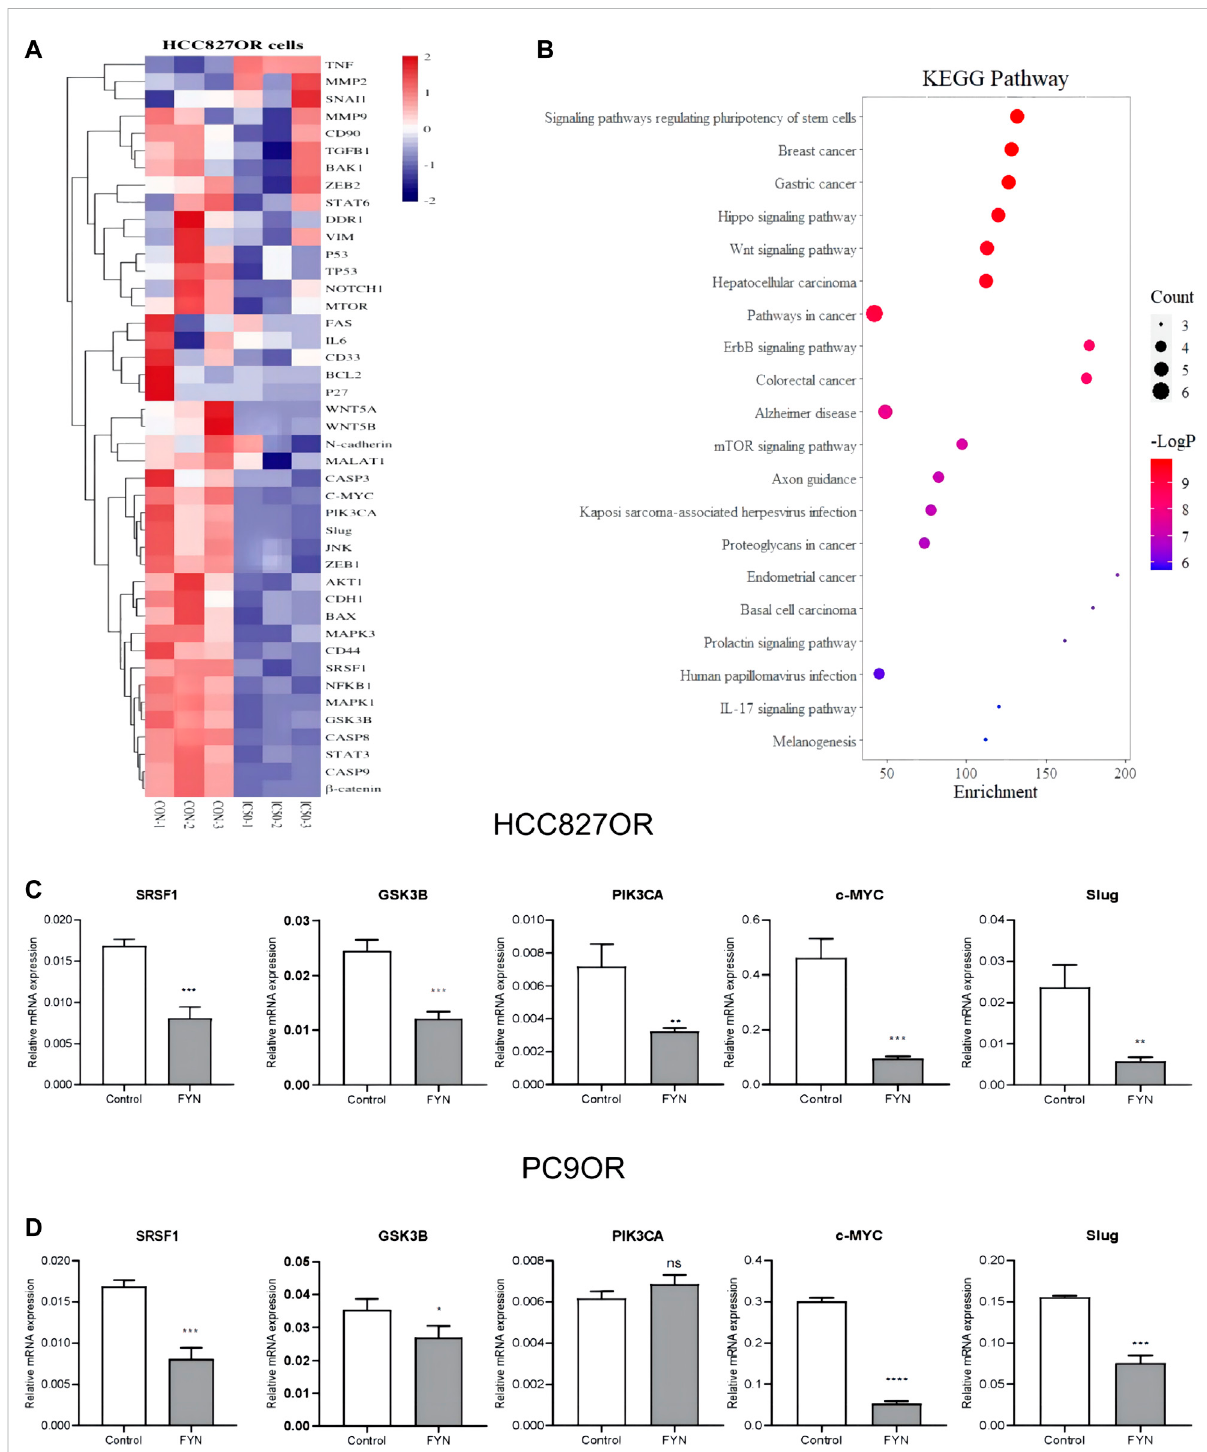
FIGURE 4 FYN downregulated the mRNA levels of genes enriched in the Wnt/ β -catenin pathway. HCC827OR cells treated with FYN at IC 50 for 48 h were harvested for analysis (A) Heatmap of target mRNA expression in control HCC827OR cells and FYN-treated HCC827OR cells. (B) KEGG analysis mostly enriched differentially expressed genes in the Wnt/ β -catenin pathway. (C and D) mRNA levels in HCC827OR cells (C) and PC9OR cells (D) were measured by qPCR. FYN, Feiyanning Formula. * p < 0.05, ** p < 0.01, *** p <